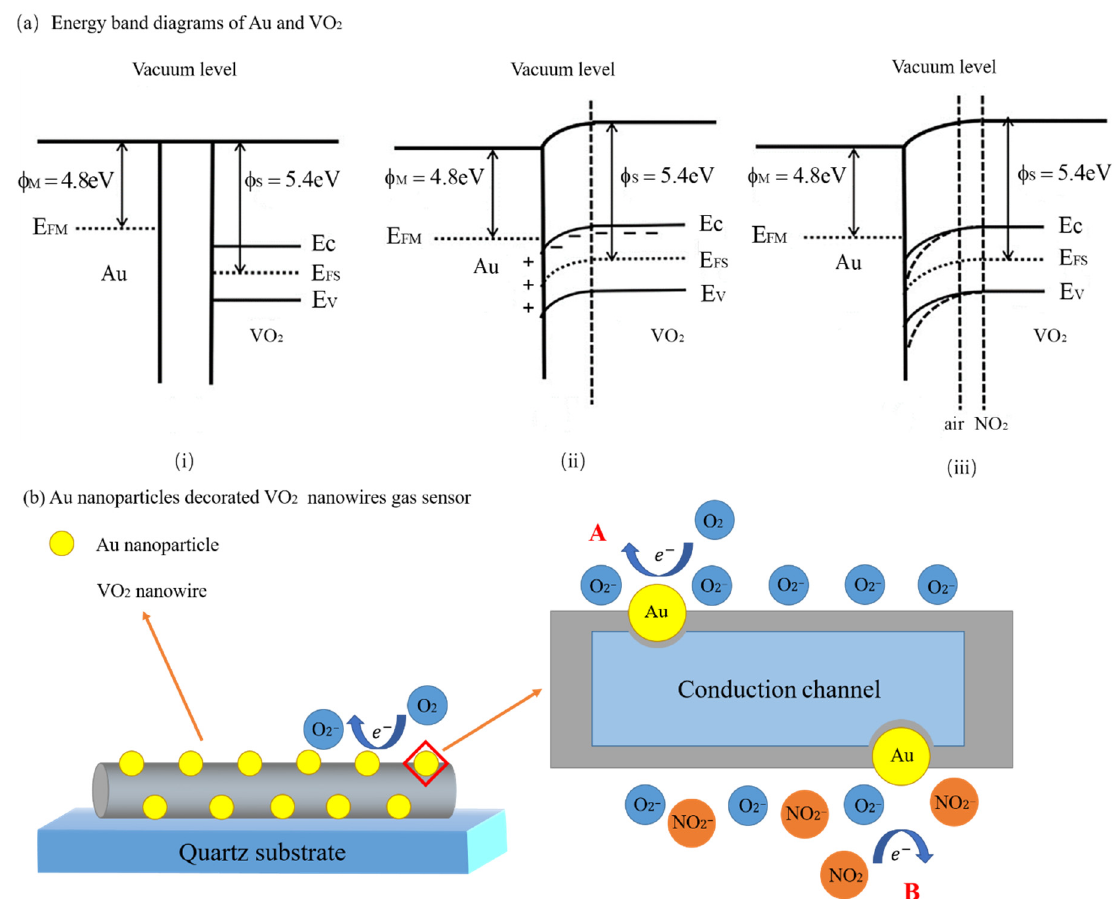
Figure 3. Schematic diagram of the mechanism of Au nanoparticles [56]. Reprinted from [56] copyright (2018), with permission from Elsevier. ( a ) The energy band diagrams of Au and VO 2 ; ( b ) The gas sensing mechanism of Au nanoparticles.